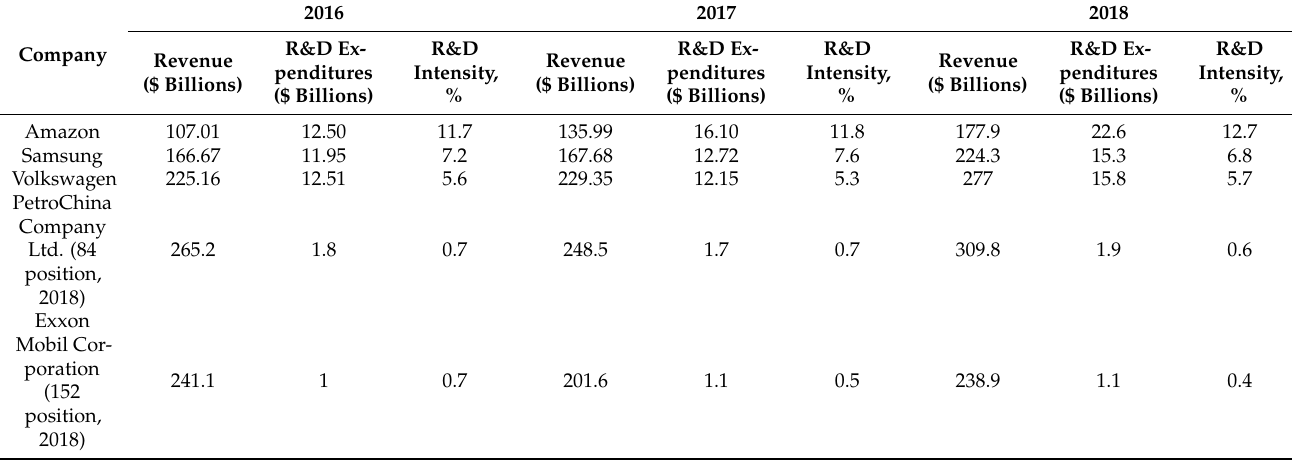
Table 1. Comparison of revenue, R&D Expenditures and R&D Intensity of innovations leaders of the world and the leaders of the Oil Companies,